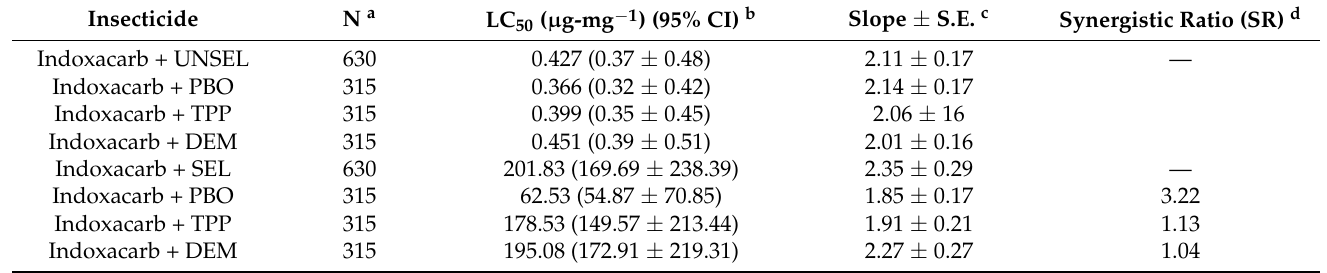
Table 4. Concentration–mortality response of S. frugiperda larvae exposed to indoxacarb and